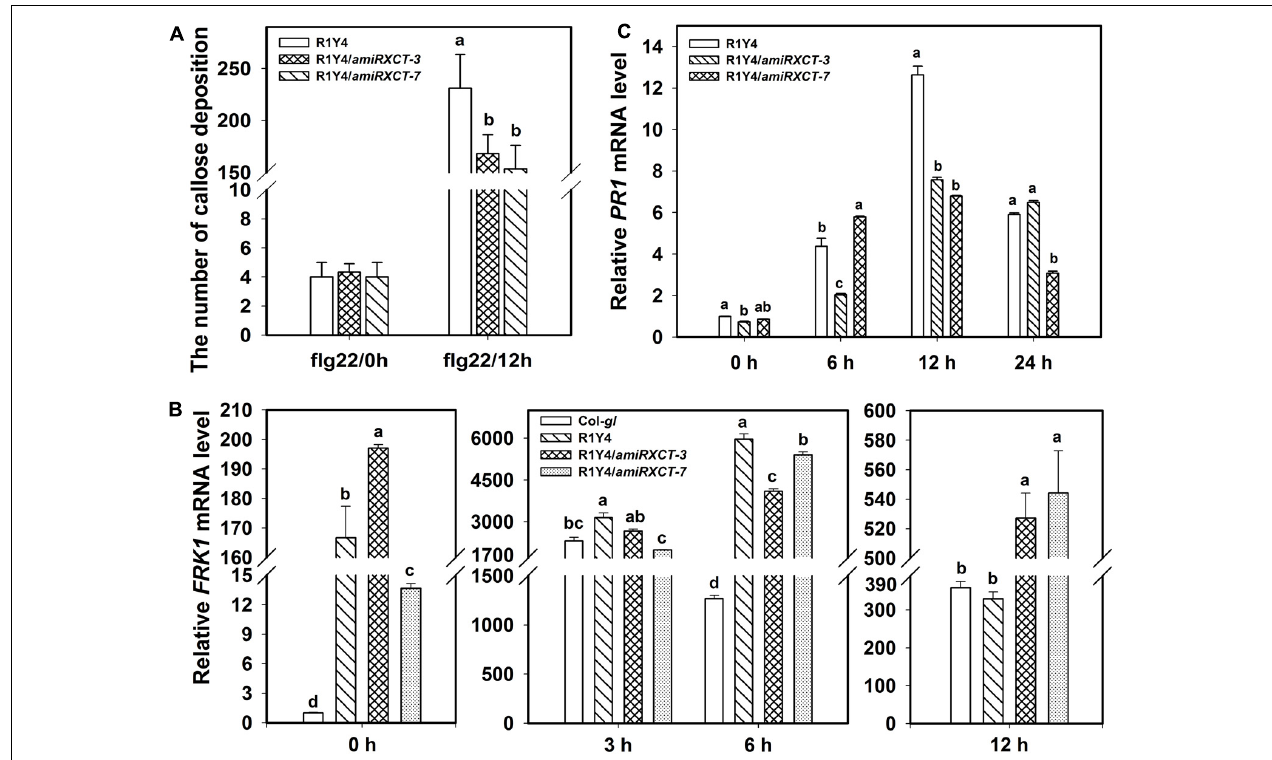
FIGURE 5 | Knocking-down XCT compromises RPW8.1 –mediated defense responses. (A–C) Quantification analysis on the number of callose deposition (A) , the relative level of FRK1 (B) and PR1 (C) induced by flg22 at the indicated time points in the indicated lines. Different letters above the bars indicate significant difference at P < 0.01. Similar results were obtained in three independent